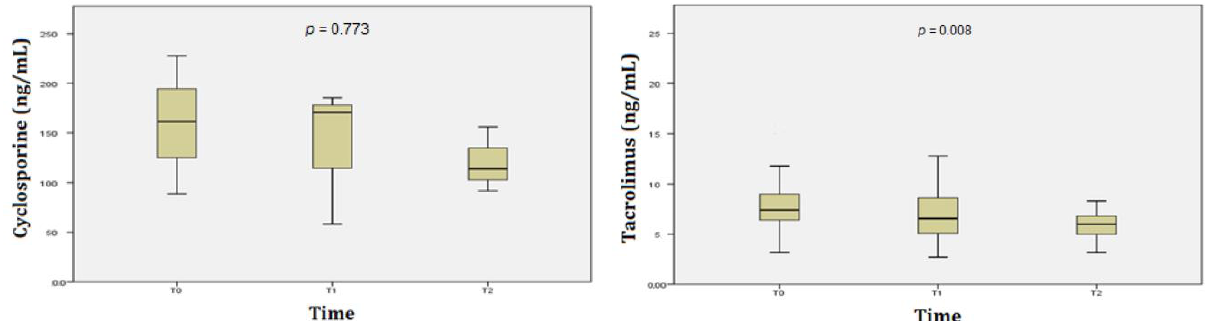
Figure 5. Cyclosporine and tacrolimus trough levels during the 6-month follow-up period in 41 KTx patients with BKV infection .